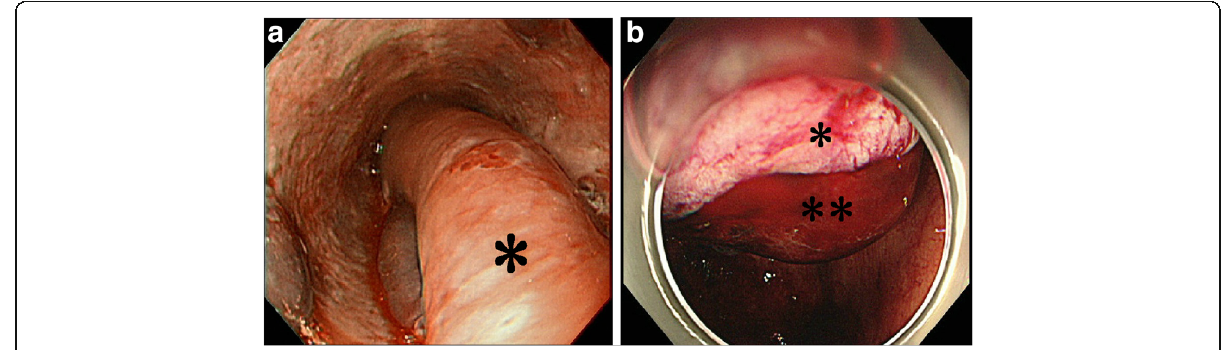
Fig. 1 Upper gastrointestinal endoscopy images immediately after hematemesis. a A longitudinal extension of reddish or wine-colored mucosal thickening (asterisk), obstructing the esophagus, is seen from the midesophagus to the esophagogastric junction. b The submucosal hematoma (two asterisks) is displacing the esophageal mucosa (asterisk) toward the gastric cavity at the esophagogastric junction. A part of the displaced mucosa has a laceration with